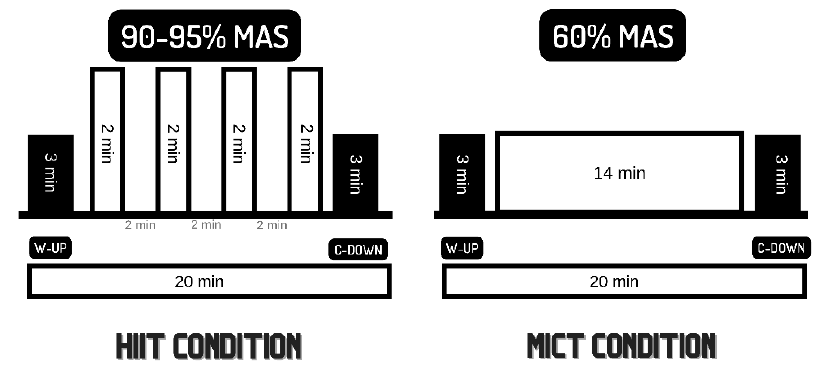
Figure 3. Exercise session design.